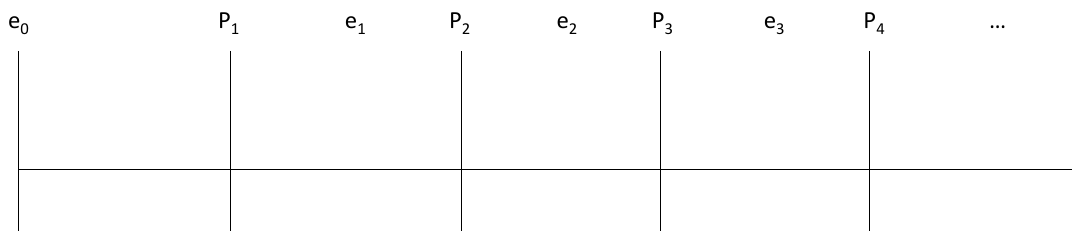
Figure 1. Timeline relating premiums (as outputs) to expenses (as inputs) for life